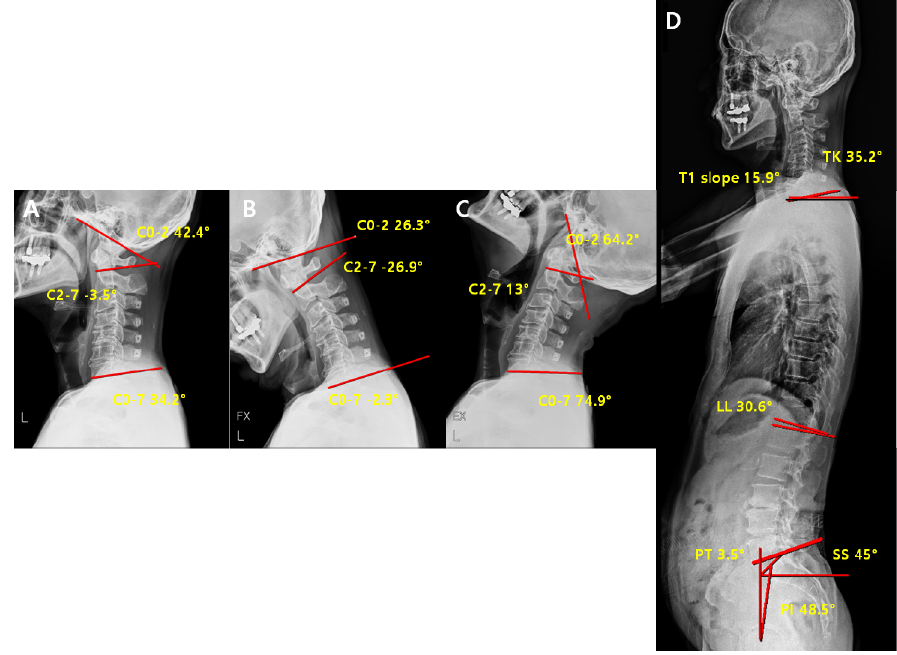
Figure 11. Post-operative radiological parameters in the non-reducible non-lordosis group. Cervical spine lateral X-ray of neutral ( A ), flexion ( B ), extension ( C ) and whole-spine lateral X-ray ( D ). Table 8. Comparison of pre-operative vs. post-operative radiological parameters of the non-reducible non-lordosis group.